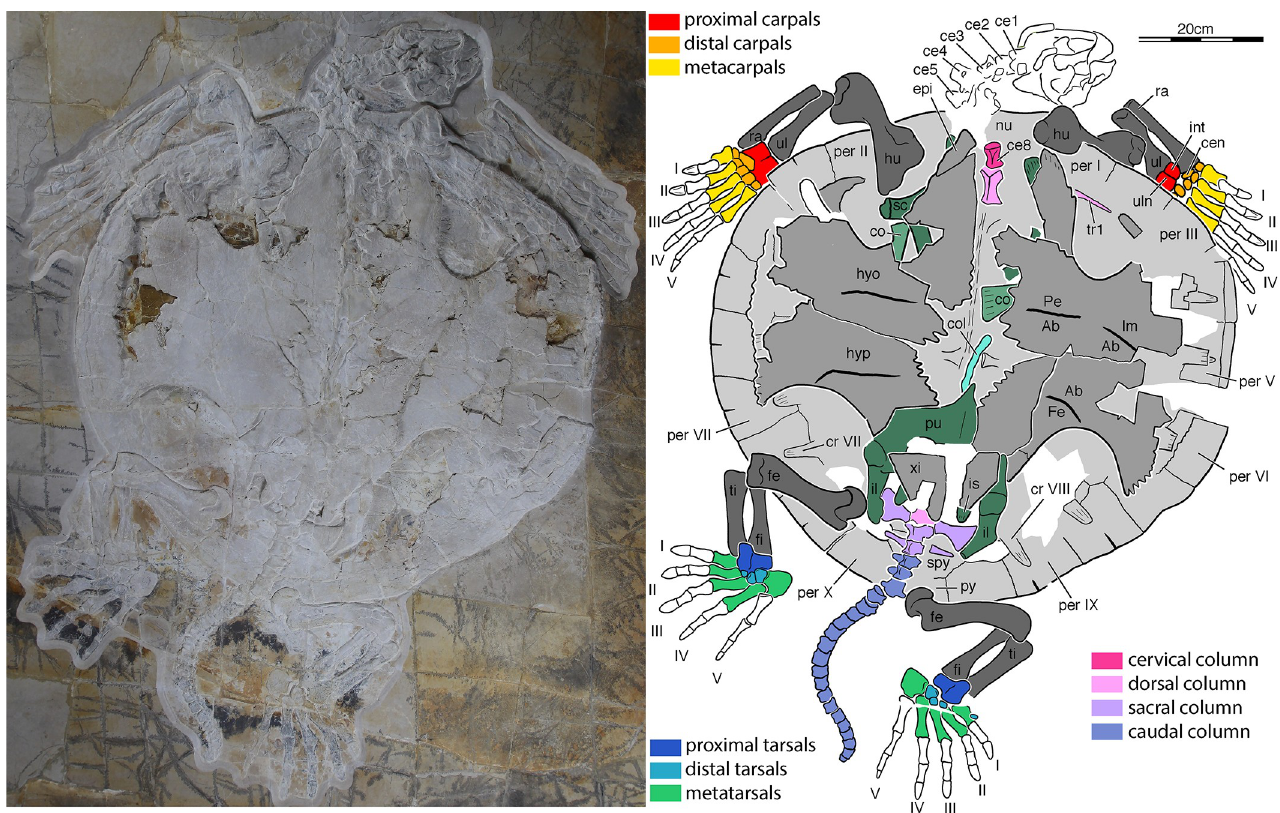
Fig 2. NKMB Watt18/211, Thalassemys bruntrutana , Late Jurassic (early Late Kimmeridgian) of Wattendorf, Bavaria, Germany. Photograph (left) and interpretive line drawing (right) of specimen in ventral view. Roman numerals denote digit identity, Arabic numerals vertebral identity. Abbreviations: Ab, abdominal scute; ce, cervical vertebra; cen, centrale; co, coracoid; col, cololite (cololith); cr, costal rib; epi, epiplastron; Fe, femoral scute; fe, femur; fi, fibula; hu, humerus; hyo, hyoplastron; hyp, hypoplastron; il, ilium; Im, inframarginal scute; int, intermedium; is, ischium; nu, nuchal; Pe, pectoral scute; per, peripheral; pu, pubis; py, pygal; ra, radius; sc, scapula; spy, suprapygal; ti, tibia; tr, thoracic rib; ul, ulna; uln, ulnare; xi, xiphiplastron.